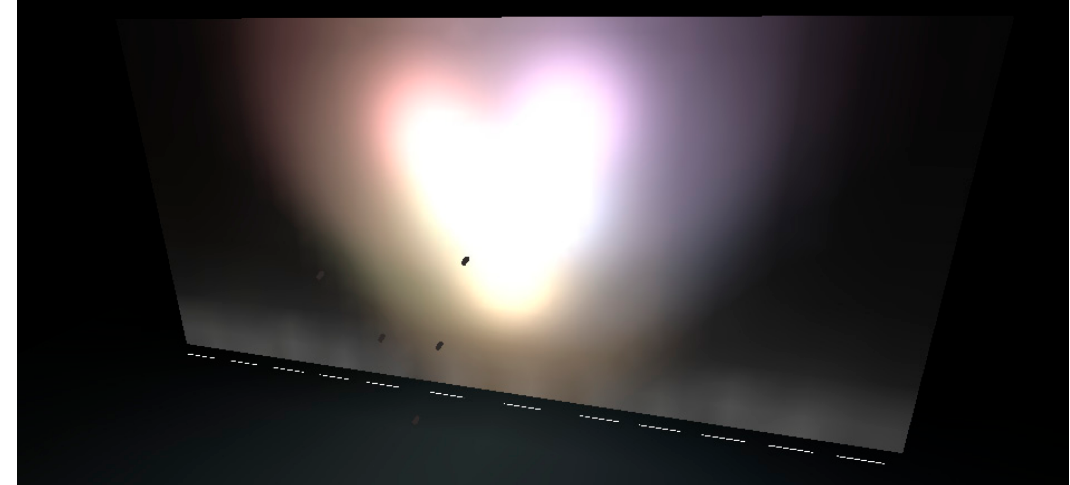
Figure 14. Simulation of visual result of Working Diagram II—Scene 1.